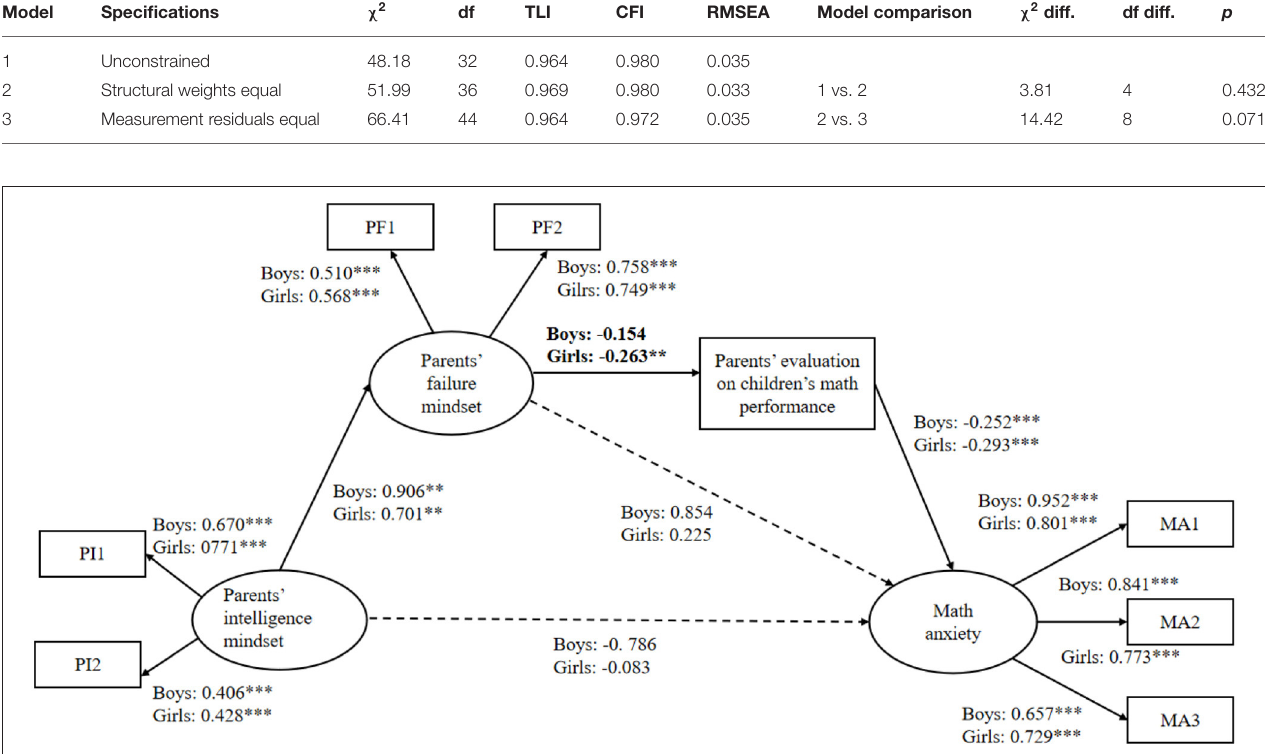
FIGURE 3 | The SEM model for boys vs. girls; *** p < 0.001; ** p < 0.01.